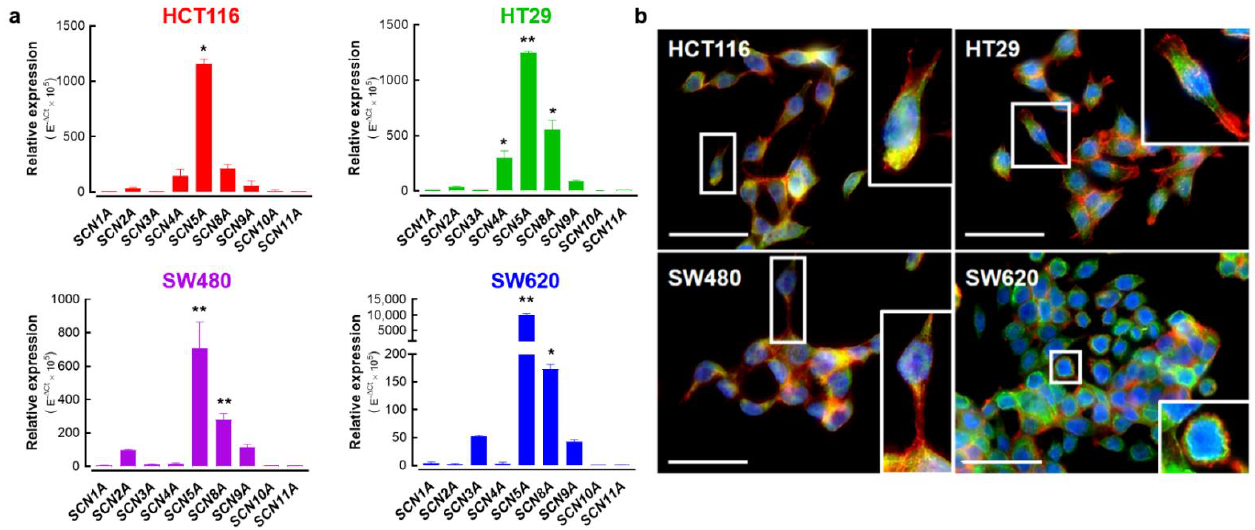
Figure 2. Expression of alpha-subunit voltage-gated sodium channels in colorectal cancer cell lines. ( a ) Bars represent the relative expression (E −ΔC t × 10 5 ) of genes encoding for alpha subunits of voltage-gated sodium channels ( SCN1A - SCN11A ) in HCT116, HT29, SW480 and SW620 colorectal cancer cells. The SCN5A gene, followed by SCN8A, were the most expressed genes in these cell lines. SCN4A was also importantly expressed in HT29 cells. ( b ) Epifluorescence microscopy analysis of Na V 1.5 proteins in HCT116, HT29, SW480 and SW620 cells. Images show the staining for Na V 1.5 proteins (green, Alexa Fluor 488), F-actin filaments (red, phalloidin-594) and nuclei (blue, DAPI). Na V 1.5 is mainly located at the plasma membrane of cancer cells. For better visualization, a threefold digital amplification was performed for the cell framed within the white box and shown on the right side of each image. Scale bar 50 µm. * p < 0.05; ** p < 0.01; Mann – Whitney rank sum test.